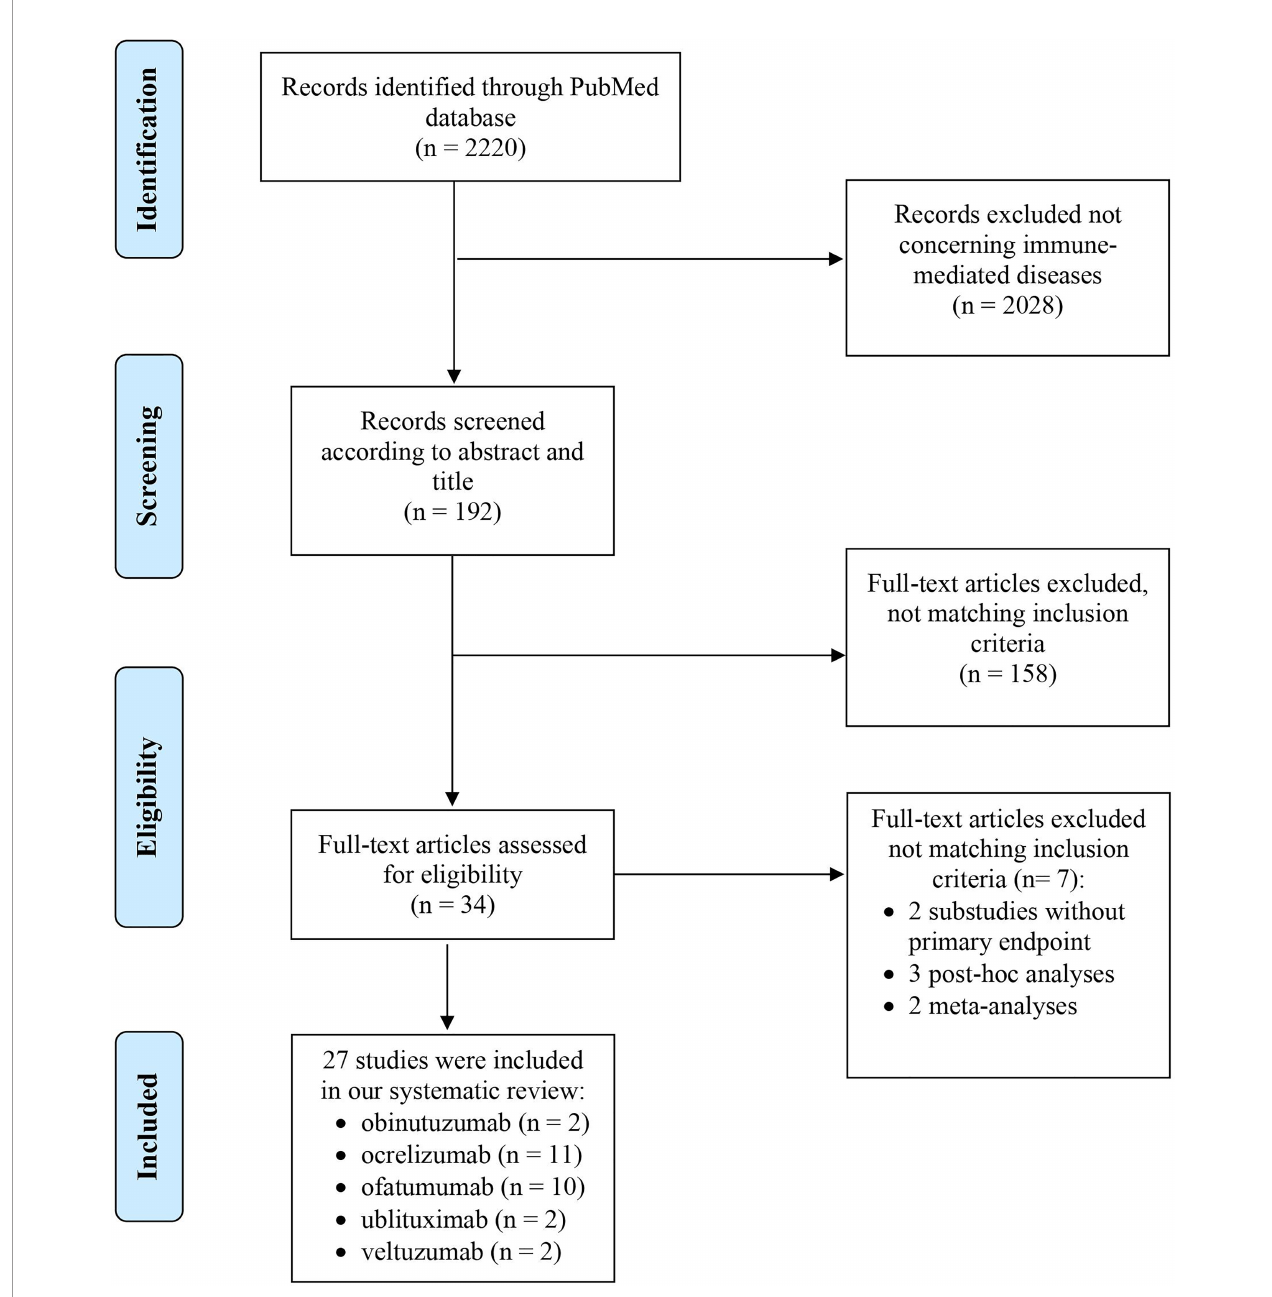
FIGURE 1 | PRISMA diagram of the literature